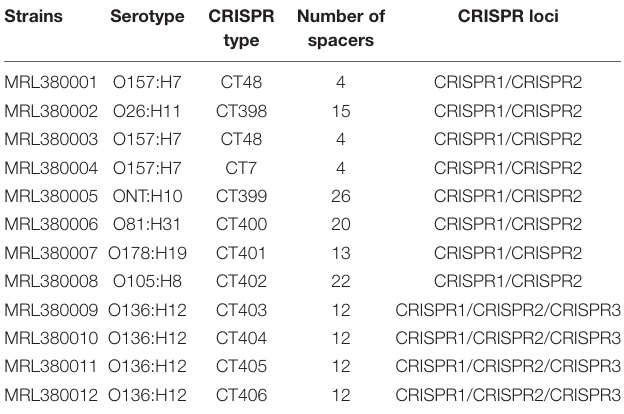
TABLE 1 | CRISPR types and serotypes of laboratory STEC.